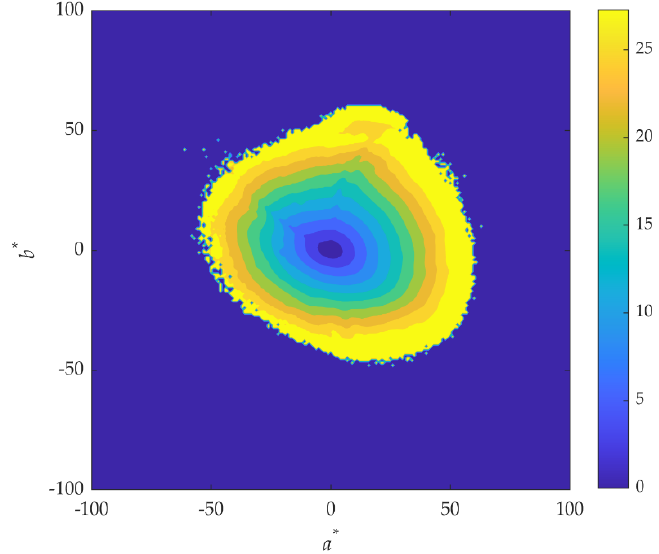
Figure 6. Color errors estimated between the RGB and the OBS in the CIELAB color space for a natural image ( a ) and a Portuguese painting ( b ) The original colors of the images are represented in Figure 2 Color bar represents the magnitude of the color errors (dark blue for no error and light yellow for a color error of 30).